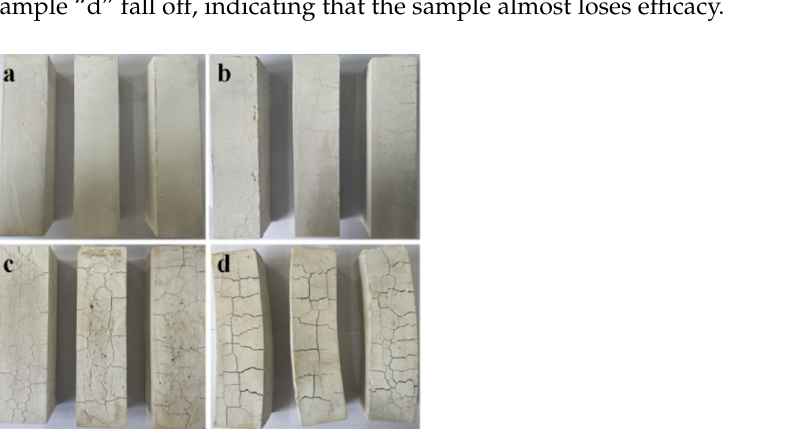
Figure 3. Measurement of the water erosion depth and sampling points.